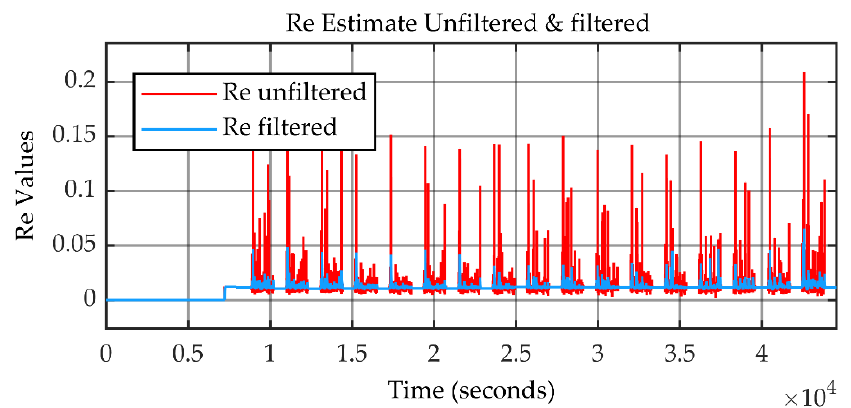
Figure 7. Unfiltered and filtered Re .